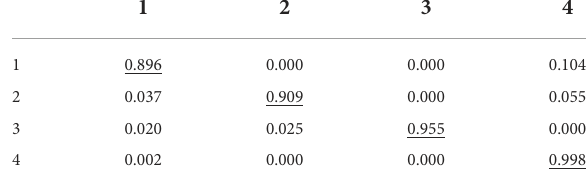
TABLE 4 Means of posterior probabilities ( N =